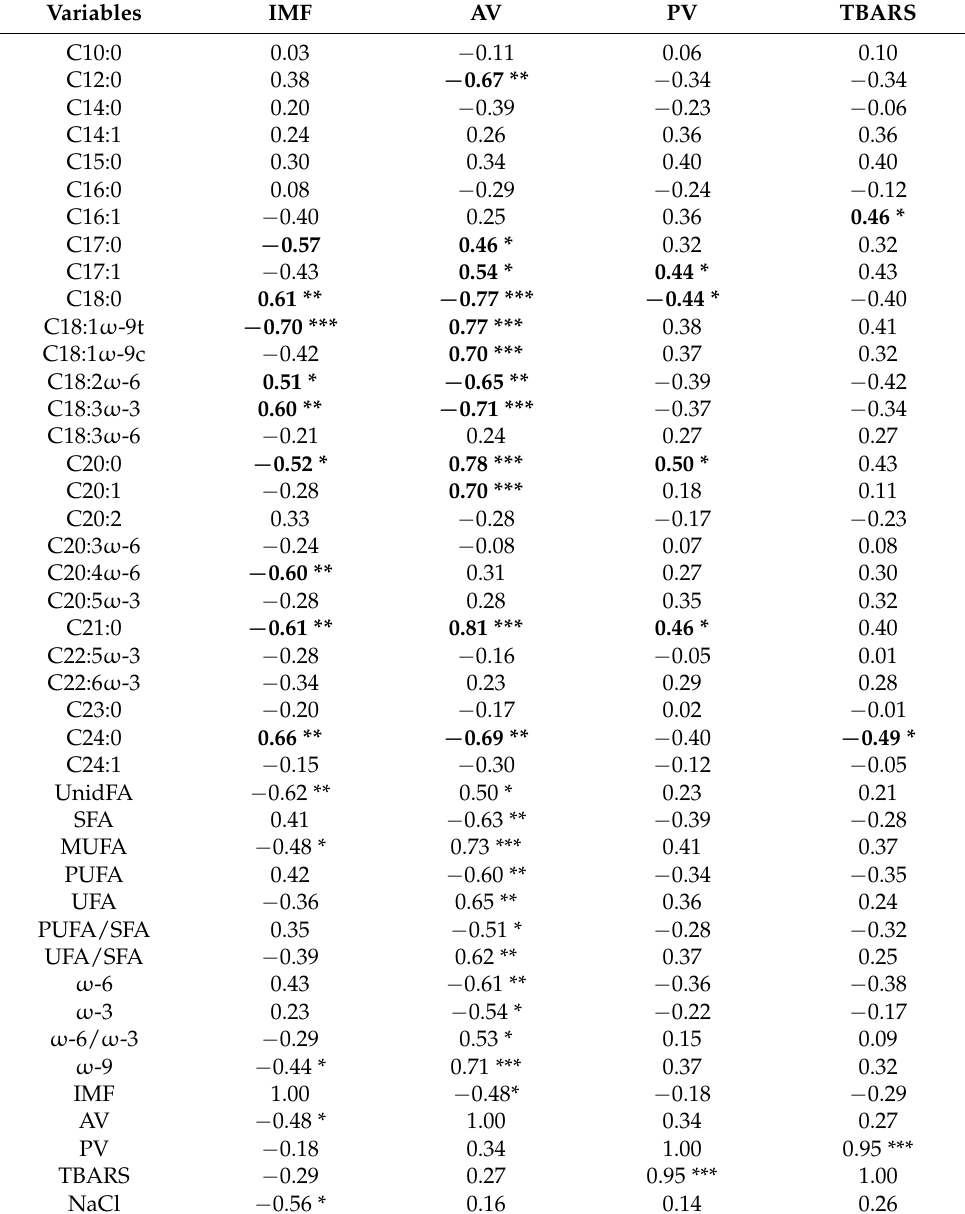
Table 7. Correlation (Pearson) matrix between individual FAs and lipolysis/lipid oxidation indicators of matured Istarski pršut , irrespective to